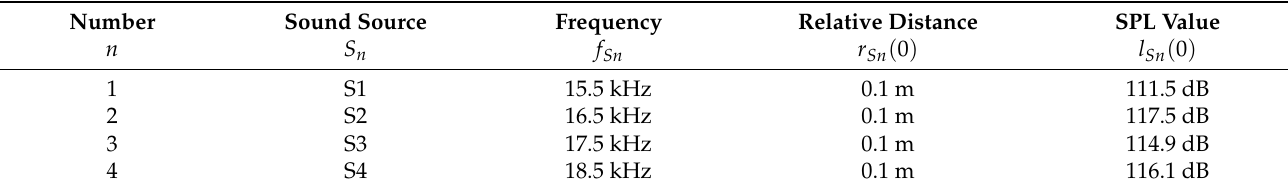
Table 3. Setting values of each tagged sound source.